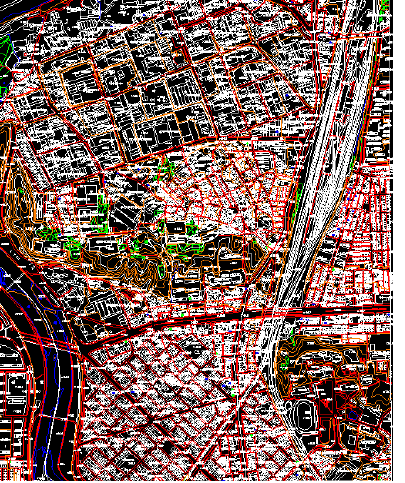
Figure 4. The reference digital map generated by aerial photo over study area.